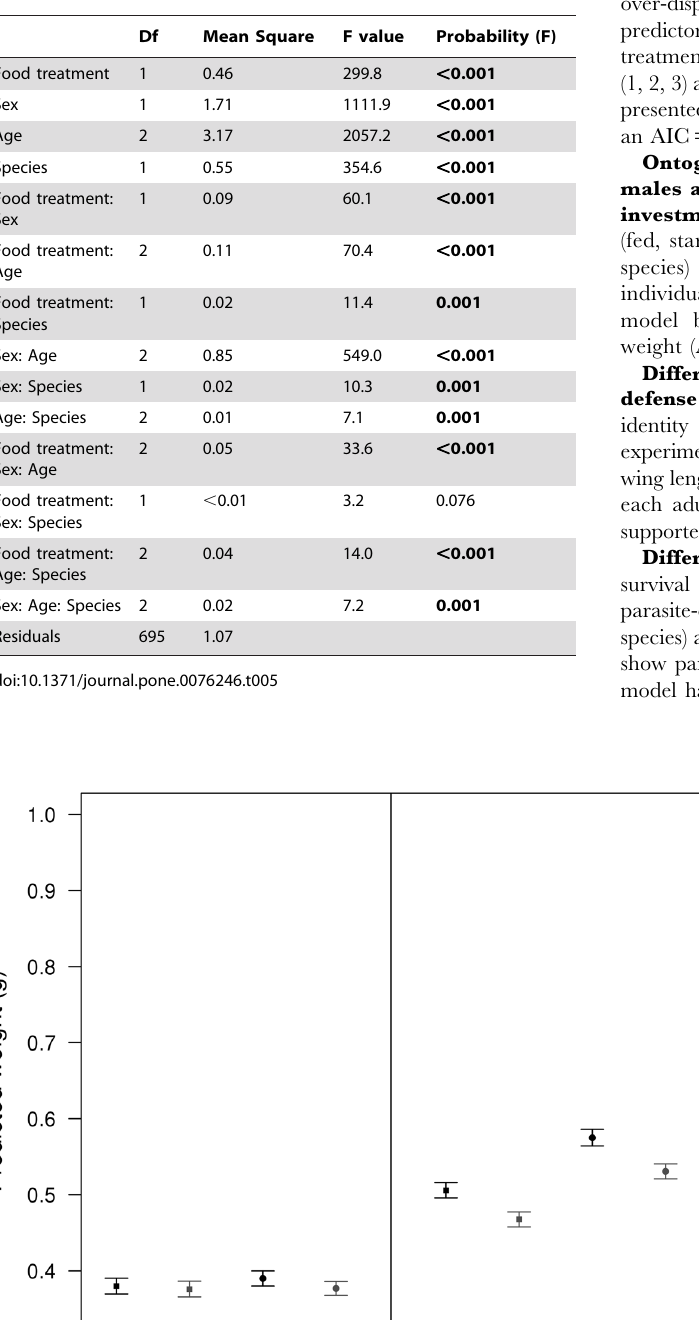
Table 5. Analysis of variance of abdominal weight according to food treatment (‘‘fed, starved’’), sex, age class and species identity.